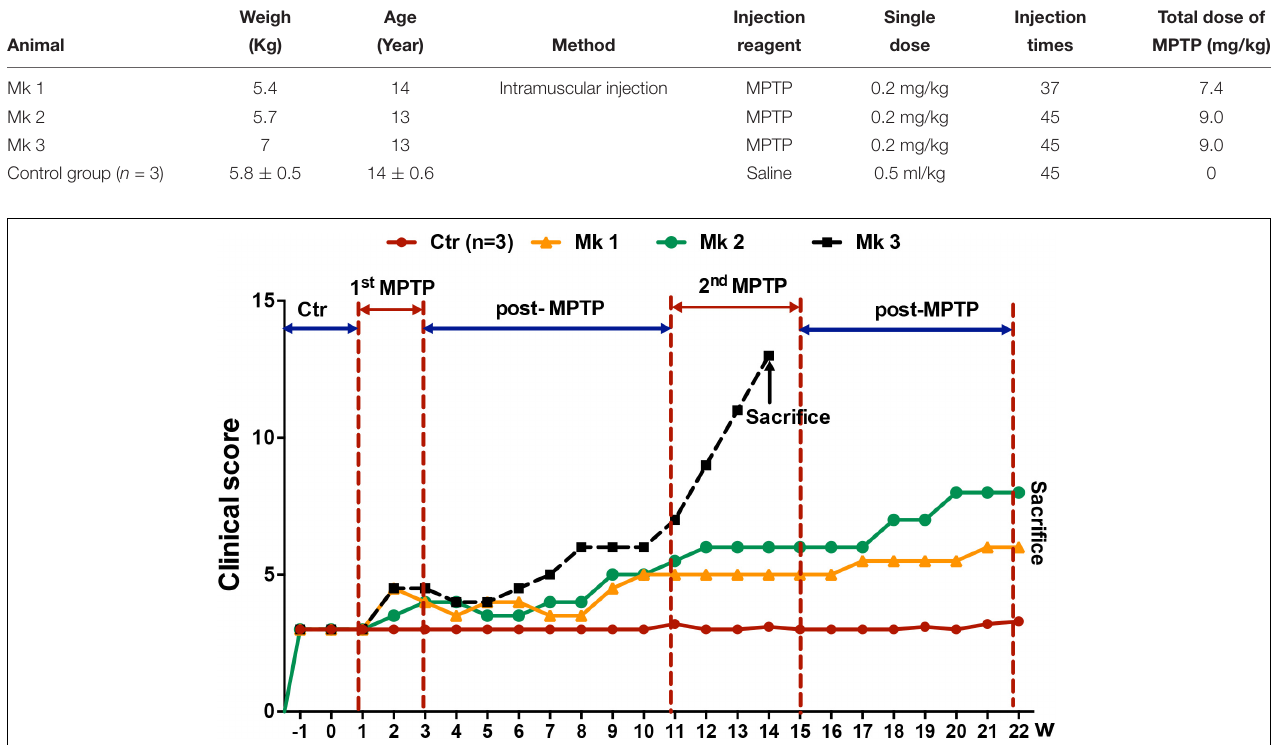
FIGURE 1 | Experimental design and clinical behavioral scores of MPTP or saline-injected monkeys. The evaluation of clinical behavioral deficits was expressed as the clinical scores which were determined weekly for up to a total of 22 weeks. Higher scores indicate more severe clinical deficits. Overall, there were a total six monkeys, three MPTP-injected and three saline-injected. The clinical score was determined for 2 weeks before injection of MPTP or saline. Note that there were two periods of MPTP injection, the first lasting for 2 weeks (1 st MPTP) and second for 4 weeks (2 nd MPTP). Both MPTP-injection periods were followed by an interval of no injection, 8 and 7 weeks. Note that the clinical score increased conspicuously starting at the beginning of 2nd MPTP injection period. Interestingly, only Mk3 showed classical clinical characteristics of PD. Unfortunately, the PD symptoms of Mk3 worsened rapidly to a level that was too severe to continue. Therefore, Mk3 was sacrificed prematurely at week 14 based on humanitarian considerations. Mk1 and Mk2, on the other hand, only developed mild PD symptoms (mild bradykinesia) and were able to continue to be observed for the entire length of study (22